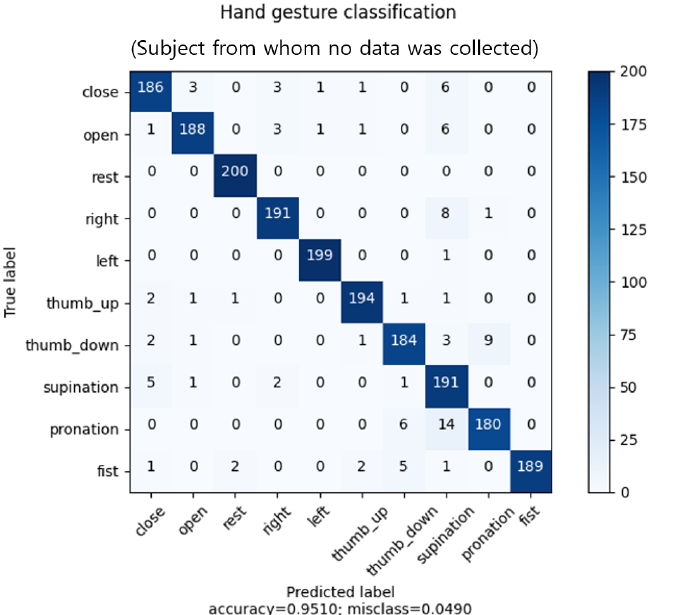
Figure 11. Confusion matrix for the subjects who did not participate in data